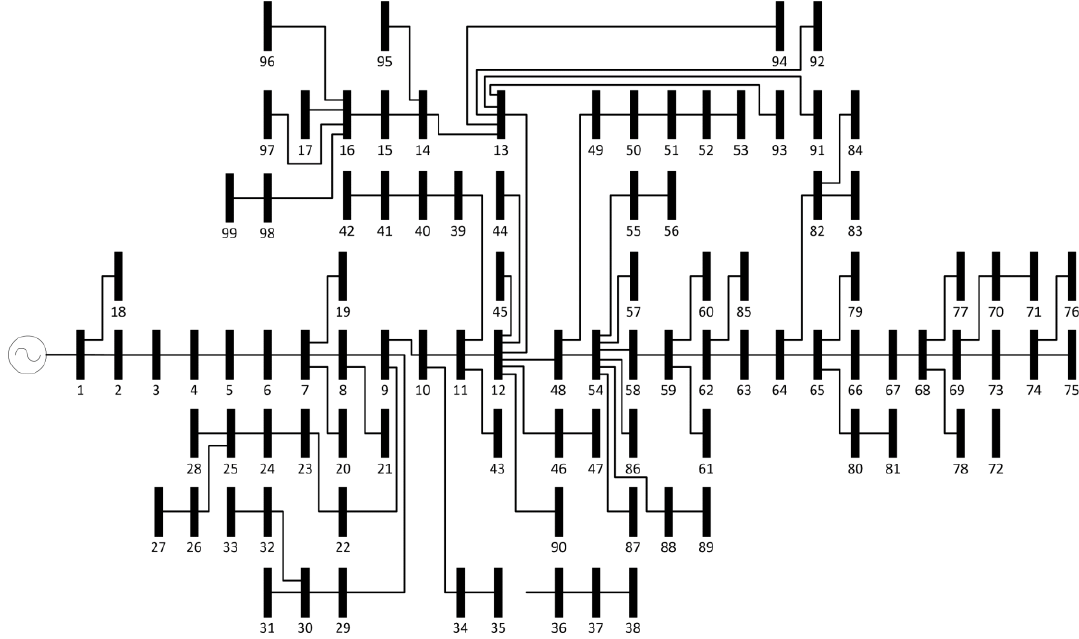
Figure 2. Single line diagram [29].